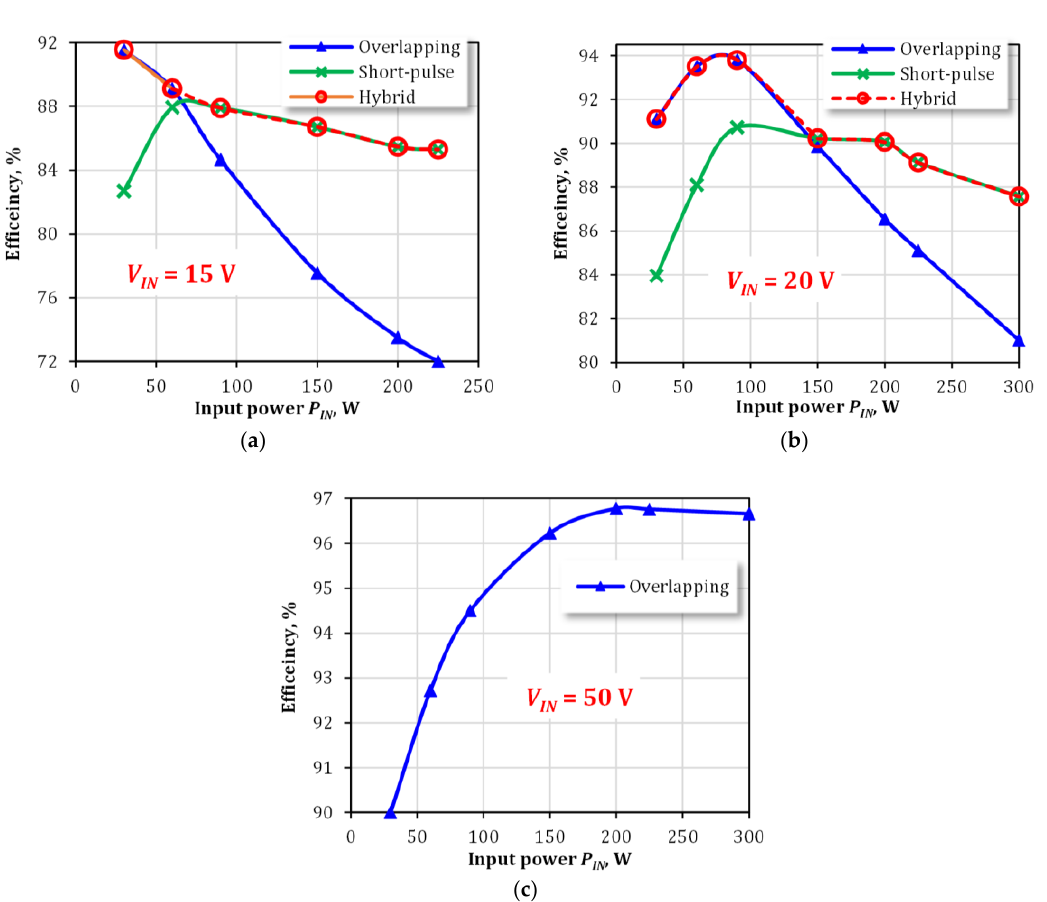
( b ) Figure 17. Experimental efficiency dependence on the input voltage for different PWM schemes evaluated at fixed input power values: ( a ) P IN = 150 W; ( b ) P IN = 200 W. 4.5. Evaluation of DC Voltage Gain with Short-Pulse PWM Scheme The proposed short-pulse PWM scheme is expected to follow the same relation between the converter DC voltage gain, which refers to the ratio between the output voltage and the input voltage, and the cumulative boosting duty cycle D b . This relation is described in Equation (16), which is applicable to the short-pulse PWM scheme at any operating point. However, its applicability to the overlapping PWM scheme is limited to the range of the normal operating conditions. Figure 18 presents a comparison between the theoretical Equation (16) depicted with a line and experimental duty cycle values for both the basic PWM scheme depicted with dots. Two values of the constant input power were selected for the tests as the converter can operate in a wide input voltage range at these power levels as shown in Figure 13. At the same time, their theoretical DC voltage gain curves are different enough to perform the comparison. It is worth mentioning, that experimental duty cycle values that correspond to the use of the overlapping PWM scheme in the abnormal operating conditions are excluded from the plots. As a result, the use of the overlapping PWM scheme is limited to the DC voltage gain values below twenty at P IN = 150 W, and below fifteen at P IN = 200 W to avoid the abnormal operating conditions. At higher values of the DC voltage gain, the short-pulse PWM scheme was used. In this way, the hybrid PWM scheme avoids excessive power losses associated with the abnormal operating conditions and makes this converter suitable for applications with a wide input voltage range. The experimental data follow the theoretical gain curve tightly at lower DC voltage gain values. More considerable differences occur at DC voltage gain values of over twenty, which is related to the converter operation at low input voltages and relatively high converter